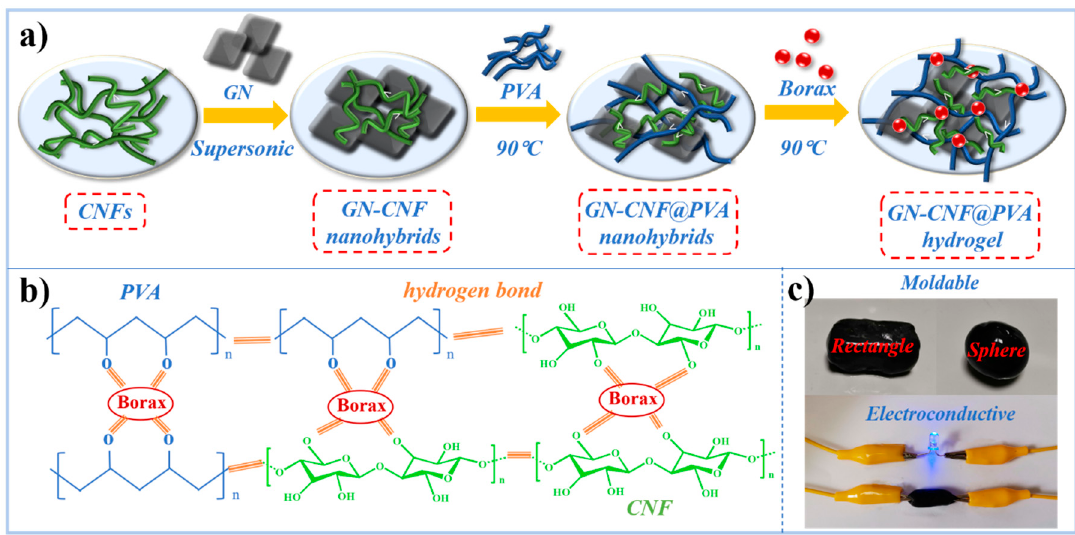
Figure 1. ( a ) Preparation process of graphene-cellulose nanofiber/poly (vinyl alcohol) (GN-CNF@PVA) hydrogels; ( b ) synthesis mechanism of the hydrogel network; ( c ) demonstration of the malleability and electro-conductivity of